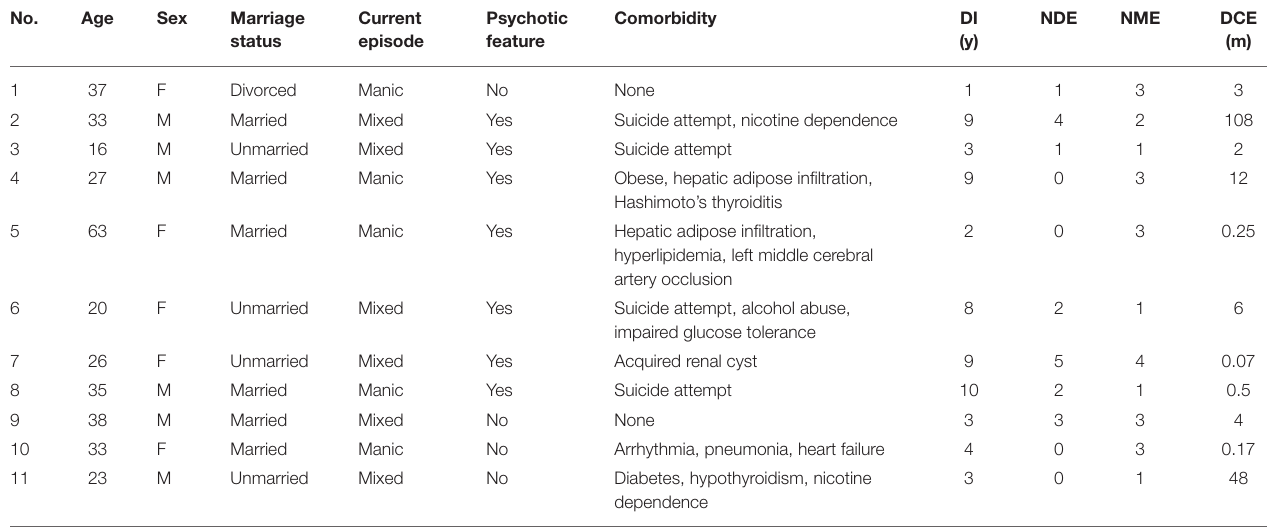
TABLE 1 | The demographic and clinical characteristics of all the participants. No. Age Sex